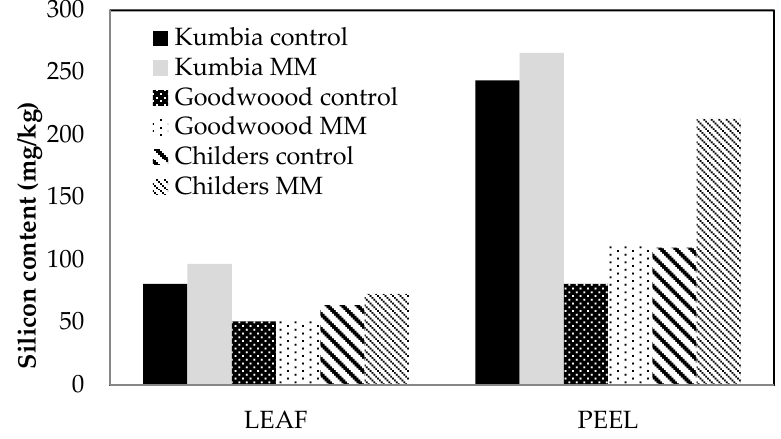
Figure 3. Silicon content (mg/kg) in dried avocado leaf and peel tissue 10 months after treatment of avocado trees at three locations in Queensland with Mineral Mulch (MM). n = 1 and thus no statistical analysis was undertaken.